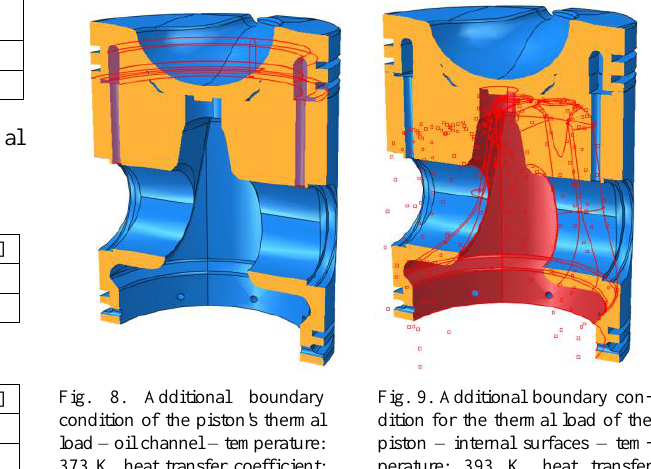
Table 3. Heat flow conditions between surfaces [3] Thermal conductivity coefficient λ [W/m K]